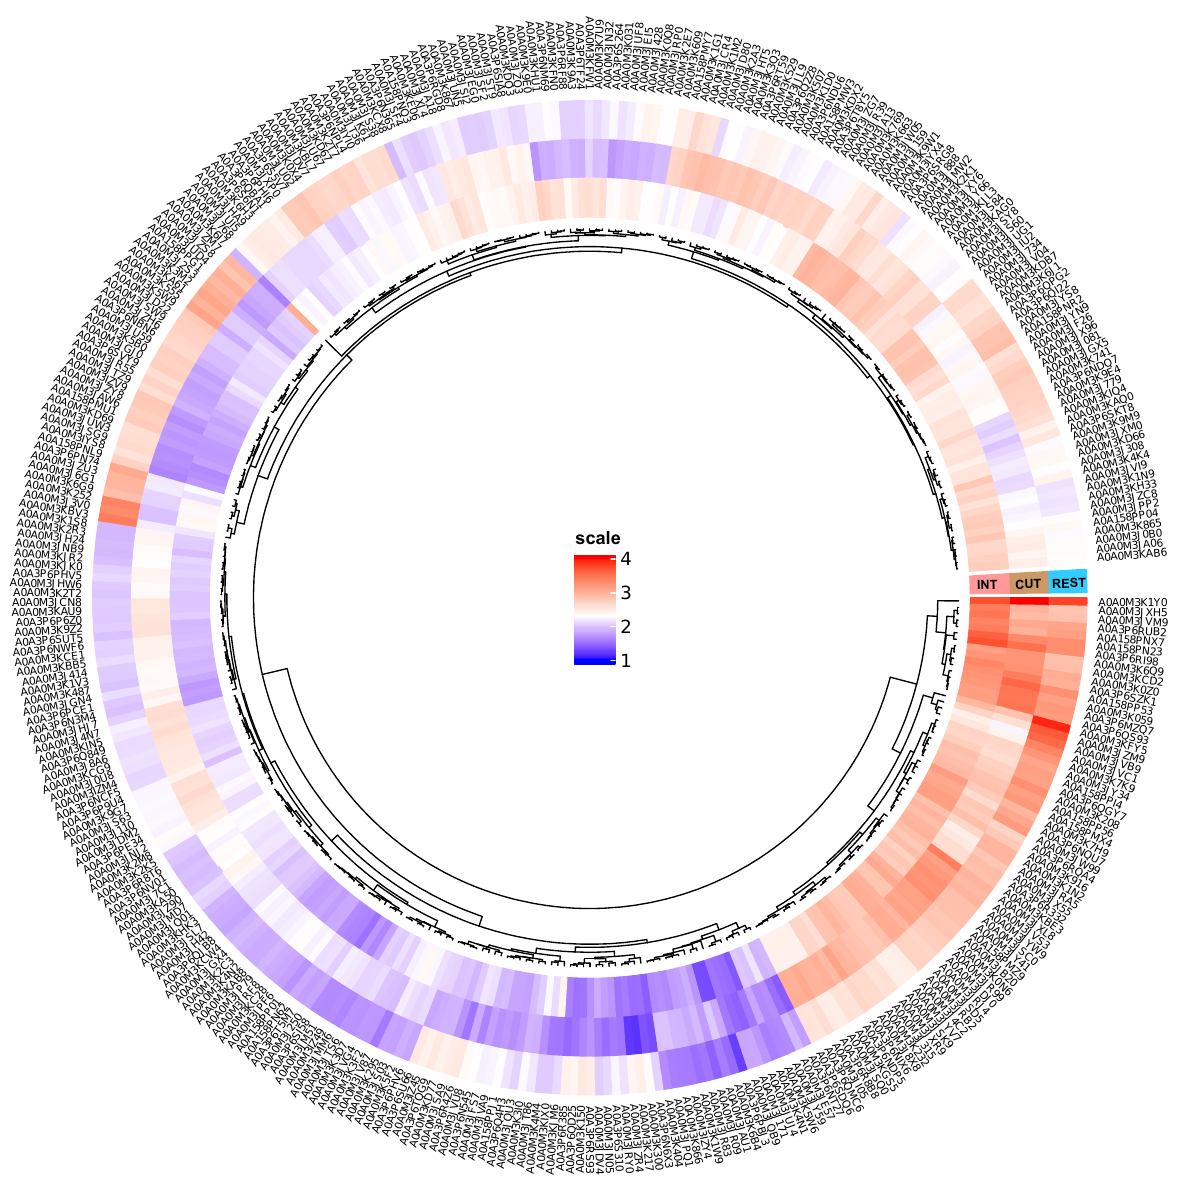
Figure 2. Visualization of the differentially regulated proteins (FC ≥ 2, p -value ≤ 0.01) between 3 tested groups: cuticle (CUT), intestine (INT), and the rest of the body of A. simplex s. s. (REST). Red and blue colors describe an increased and decreased abundance in the compared groups, respectively. The detailed list of DRPs in each of the compared groups is presented in File S1. Among the proteins found in the intestine (File S1), we identified those with catalytic activity, including carboxypeptidase (A0A0M3K6G9), glutamate dehydrogenase (A0A0M3JI05), fructose-bisphosphate aldolase (A0A0M3JYW9), alanine-glyoxylate ami- notransferase (A0A0M3K6B4), or aminopeptidase (A0A3P6SUT5), and proteins that in- volved both oxidative phosphorylation and the tricarboxylic acid cycle (the processes that generate energy), e.g., oxoglutarate dehydrogenase (A0A0M3JPF6) and succinate dehy- drogenase (A0A0M3JRB2).